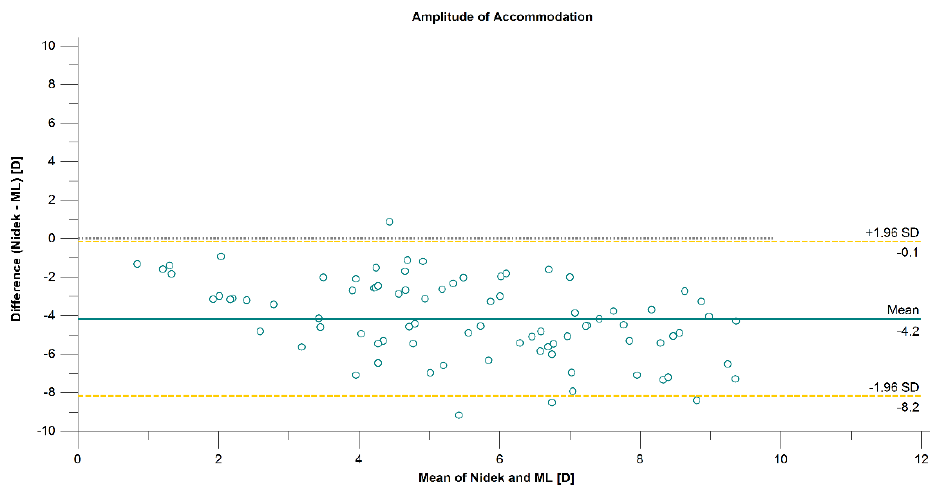
Figure 4. Agreement in amplitude-of-accommodation measurements between the Nidek autorefrac- tor and the minus-lens (ML) method associated with 95% CI for